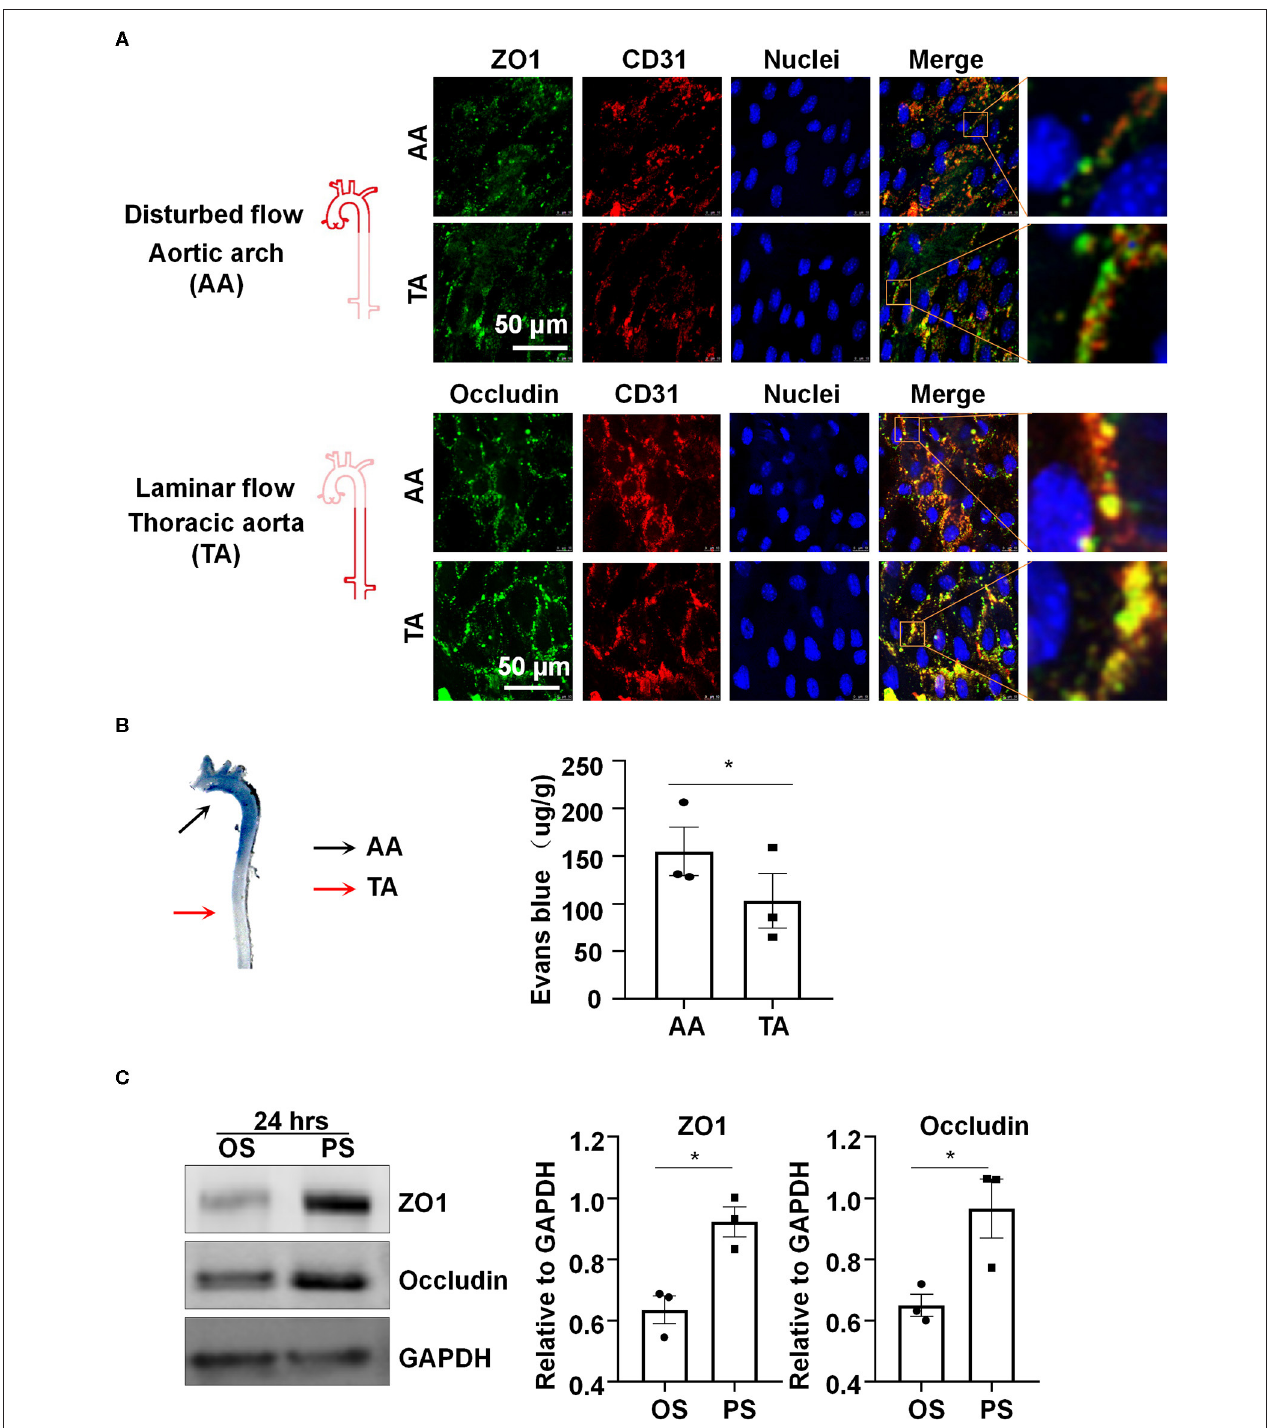
FIGURE 1 | Laminar blood flow with uniform and pulsatile shear (PS) protects the endothelial barrier function and maintain the expressions of the tight junction proteins ZO1 and Occludin. (A) Cellular localizations of ZO1 (green), Occludin (green), and CD31 (red) from the inner curvature of the aortic arch (AA) or from the thoracic aorta (TA) of C57BL/6 wild type mice were assessed by en face immunofluorescence. Images are representatives of 3–5 independent experiments with similar results. (B) Evans blue (30 mg/kg in 100 ul PBS) was injected into tail vein of mice with an insulin needle, and the aortas were isolated for photographing to observe the leakage of Evans blue in the aortic wall. Evans blue dye was extracted from aorta arch with formamide and measured spectophotometrically at 620nm to determine endothelial permeability. Each symbol represents one animal. Paired t -test. * P < 0.05 compared with the indicated controls. (C) HUVECs were exposed to pulsatile shear (PS, 12 ± 4 dynes/cm 2 ) or oscillatory shear (OS, 0.5 ± 4 dynes/cm 2 ) for 24h, and the expressions of ZO1 and Occludin were analyzed by Western blot. Semi-quantification of the blots are shown in the right panels. Unpaired t -test. * P < 0.05 compared with the indicated controls.